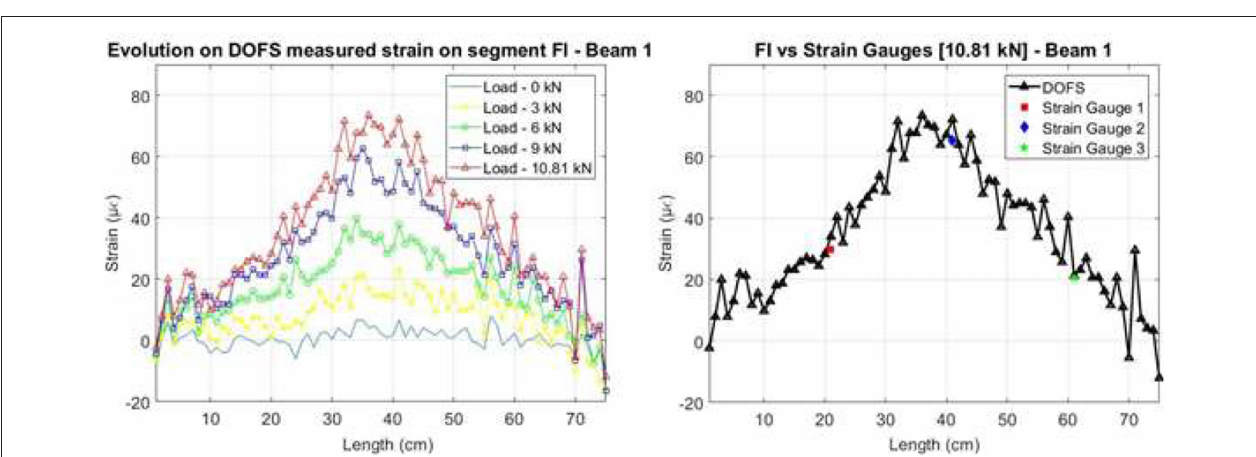
FIGURE 4 | Strains measured by the DOFS on the embedded segment for Beam 1.